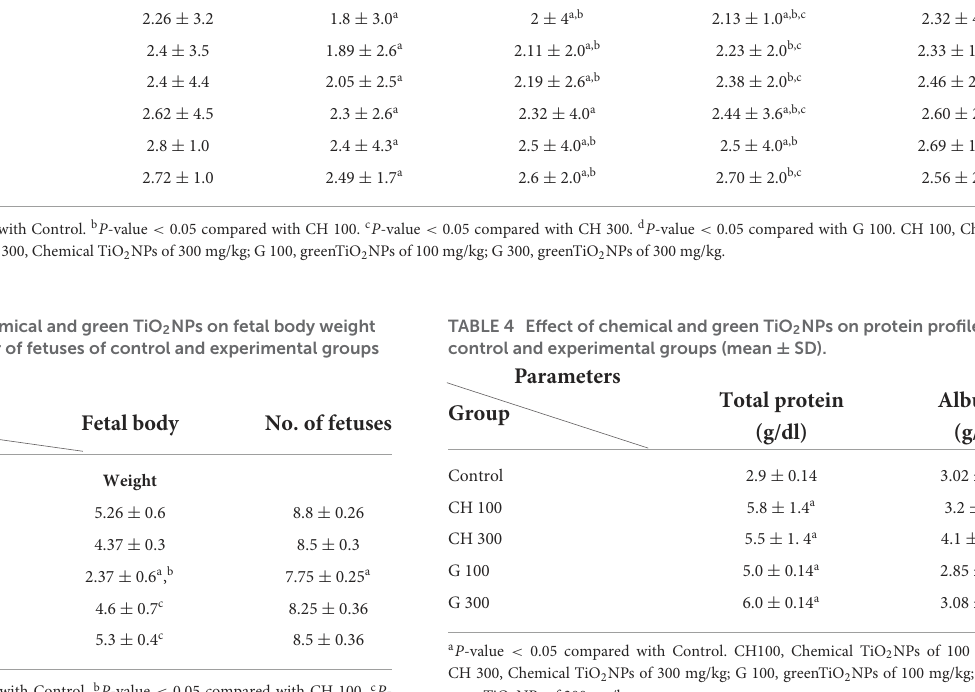
TABLE 1 Effect of chemical and green TiO 2 NPs on maternal body weight (g/kg) of control and experimental groups. gestationGroup Dayof